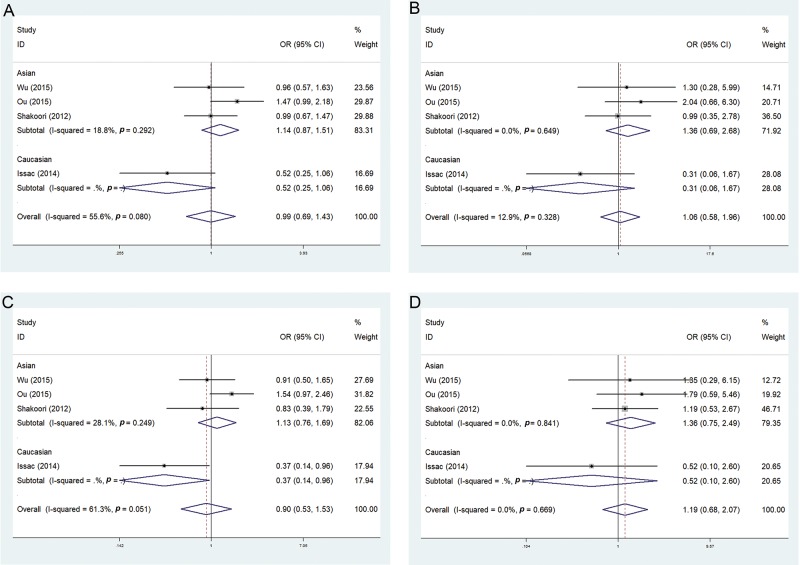
Forest plots of the association between the rs2243639 polymorphism and the risk of COPD (A, allelic model; B, additive model; C, recessive model; D, dominant model).